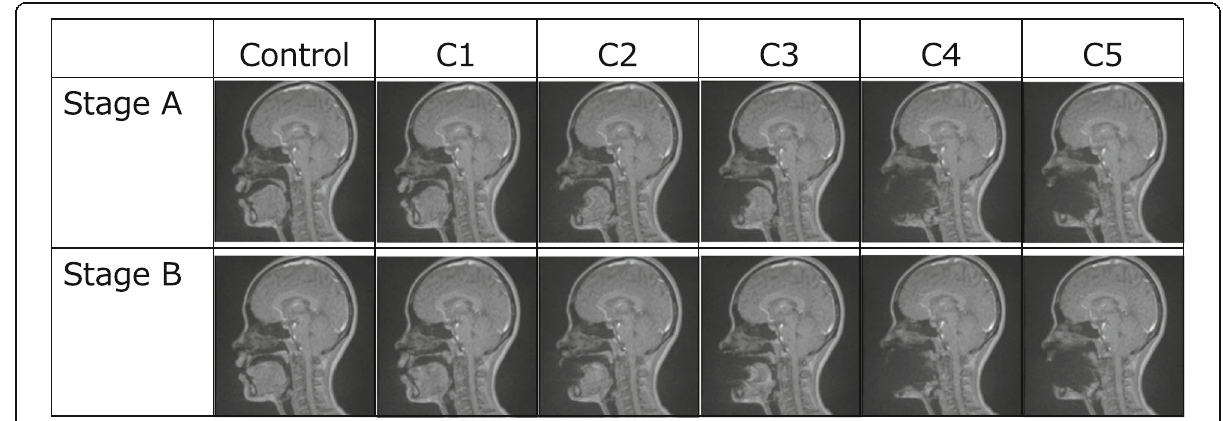
Fig. 4 Magnetic resonance movie images in six conditions at stages A and B